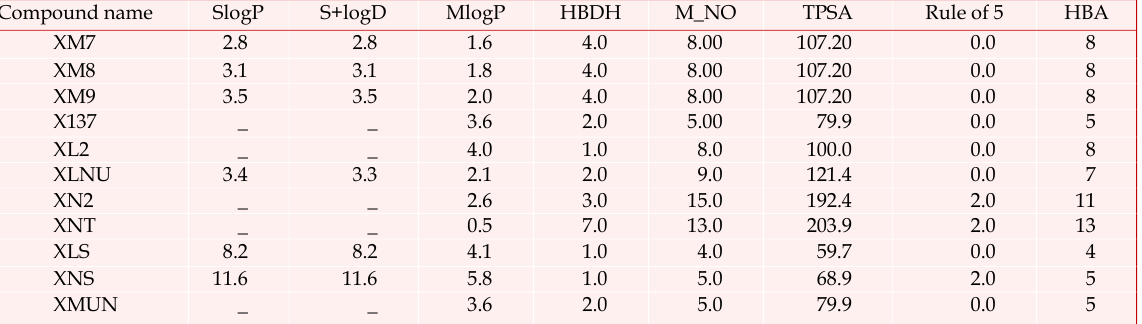
Solubility, drug likeness and drug score accounted by Osiris property explorer and with respect to binding energies of different novel